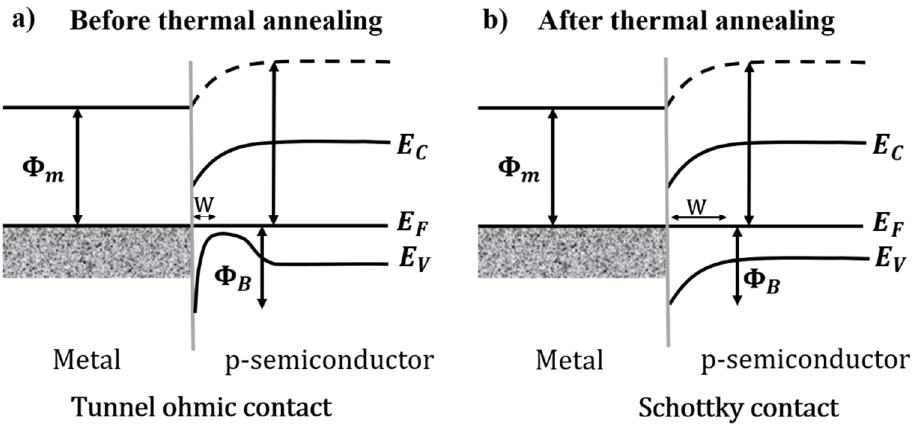
Figure 8. Suggested energy band diagram of the ITO/CdS/PbSe heterojunction as a metal-semiconductor (p-type), ( a ) before and ( b ) after thermal annealing, assimilating the ohmic and rectifying electrical response obtained, respectively. On the other hand, Qiu et al. [20] reported a PbSe-QDs/CdS/CdSe:In/Si heterojunc- tion. They proposed a possible application of their heterojunction as an uncooled mid-